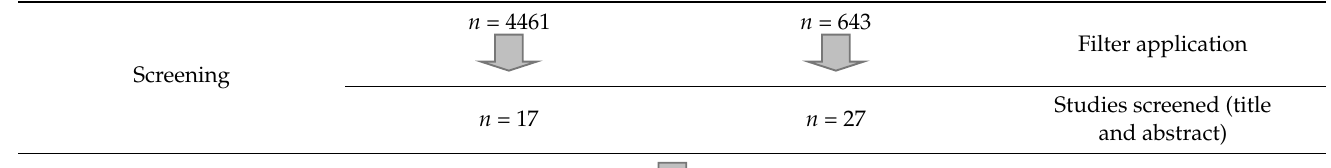
Table 2. Search strategy and results of identification, screening for eligibility, and inclusion of pub- lications considered for review. Table 2. Cont.